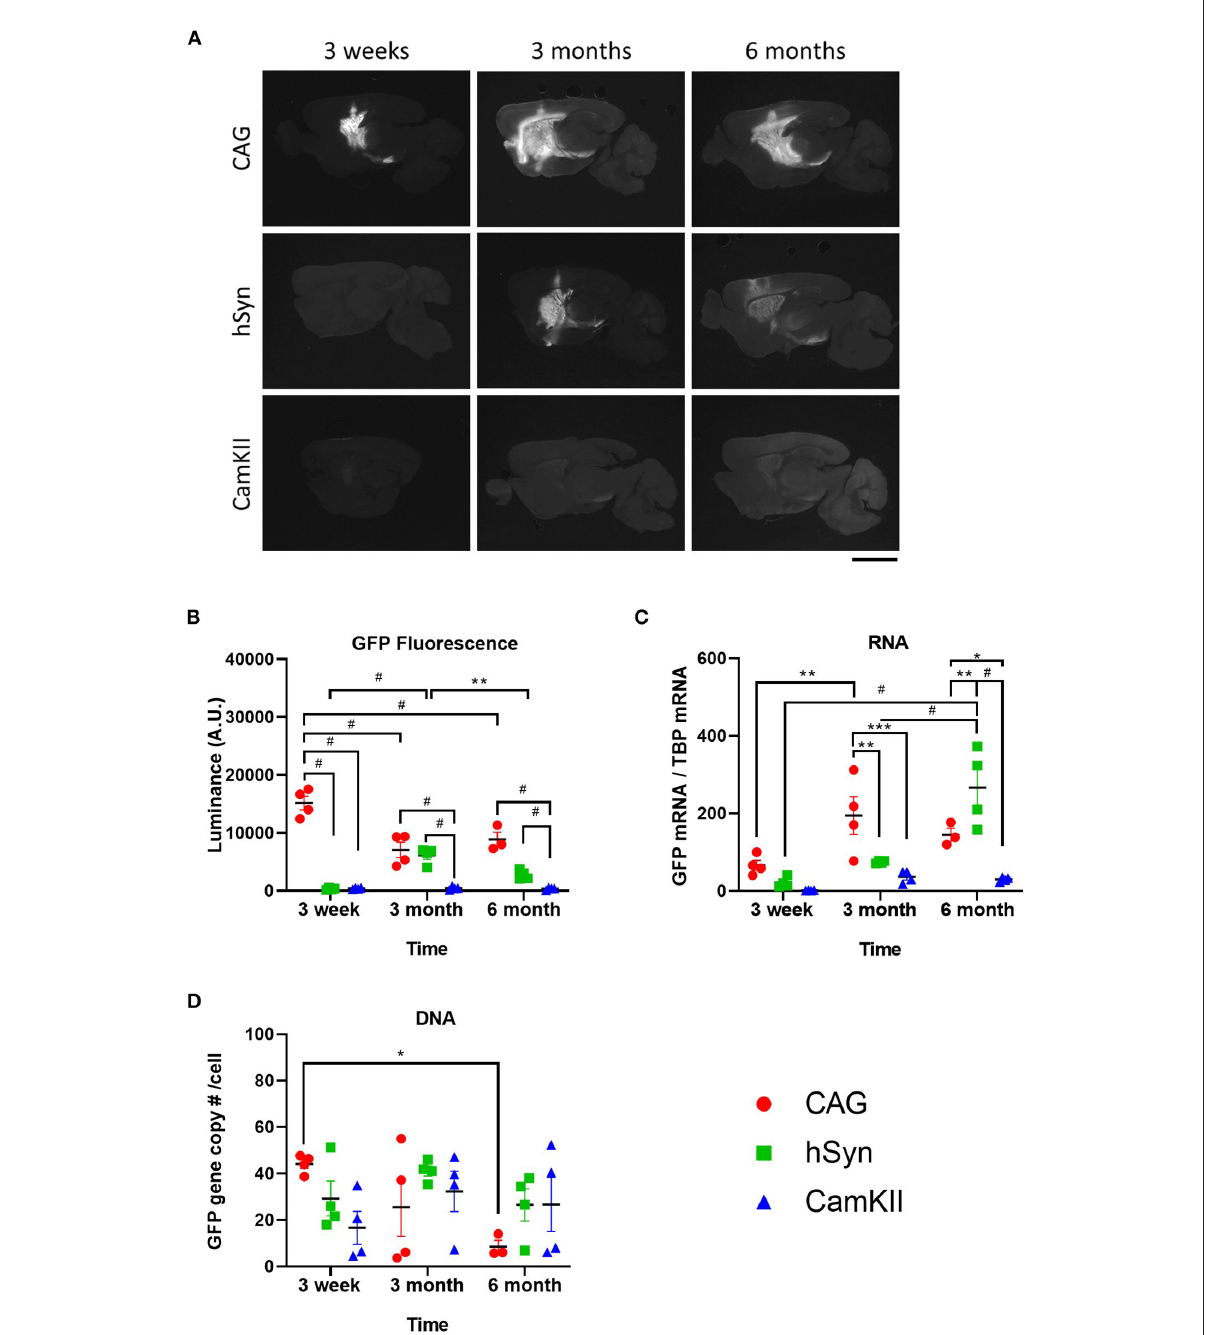
FIGURE2 Long-term kinetics of rAAV9 genomes, transcripts and protein expression in the striatum in mice stereotaxically injected with rAAV9-CAG-GFP, rAAV9-hSyn-GFP, or rAAV9-CamKII-GFP. (A) Images and (B) quantification of luminance of native GFP fluorescence (500ms exposure) at 3 weeks, 3 and 6 months after rAAV9-GFP administration. Scale bar represents 3mm. (C) Amount of GFP mRNA relative to TBP mRNA and (D) GFP DNA copies per cell as determined by copy of GFP to two glucagon copies per cell. Data was analyzed using a two-way ANOVA followed